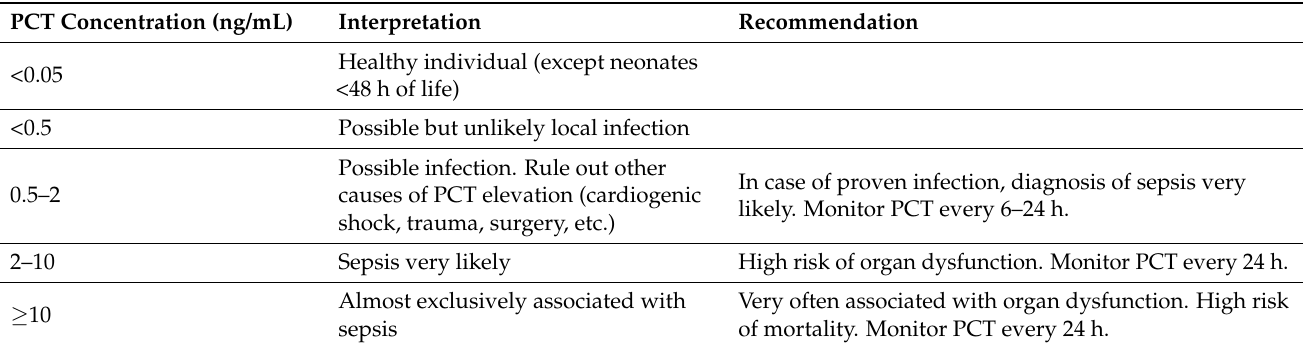
Table 2. PCT references values and their interpretation in sepsis.